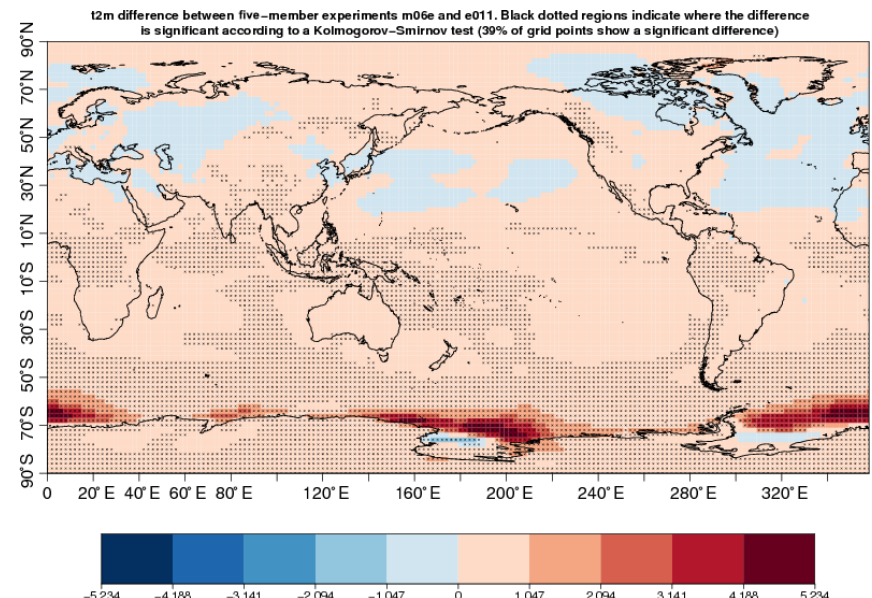
Figure 5. Difference in 20-year mean and ensemble mean near-surface air temperature between the experiments m06e and e011 (red means m06e is warmer). Dots indicate pixels in which the two five-member samples are statistically incompatible according to the KS test (see Sect. 3.2.3).